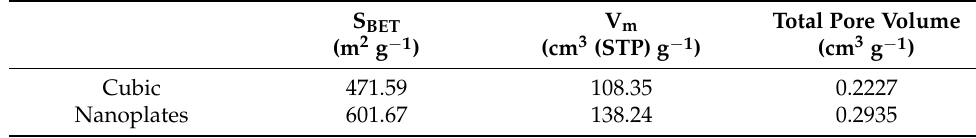
Figure 8. N 2 adsorption–desorption BET-isotherms of cubic (S13) and nanoplate (S15) type SAPO-34 particles. Table 3. Surface area characteristic of the SAPO-34 particles.